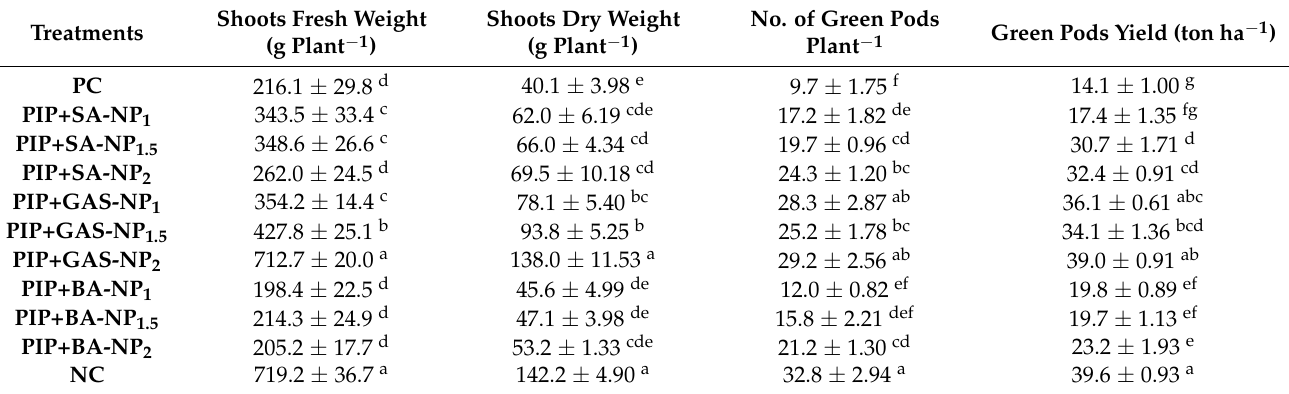
Table 4. Effects of foliar-applied salicylic acid (SA-NP), glycyrrhizic acid (GAS-NP), and boric acid (BA-NP) nanoparticles on biomass and green pods yield of phytoplasma-infected faba bean plants.